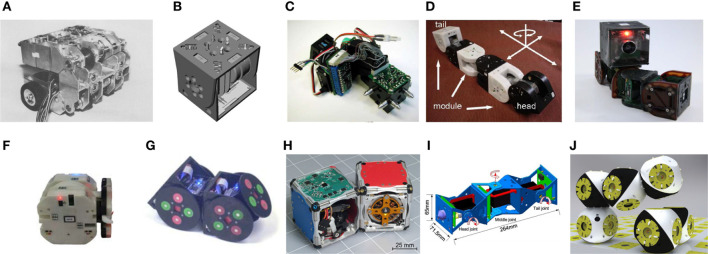
Cell-inspired robots. (A) The Mark II implementation of CEBOT [Reprinted by permission from Springer Nature Terms and Conditions for RightsLink Permissions Springer Customer Service Centre GmbH: Springer Nature, Journal of Intelligent and Robotic Systems (Fukuda and Nakagawa, 1990), CC BY (1990)]; (B) rendering of a single module of PolyBot model G3 (© [2018] IEEE. Reprinted, with permission, from Yim et al., 2002); (C) a single module of CONRO robot (Payne et al., 2004) (Reprinted by permission from Rubenstein, Payne, Will, Shen/USC, ISI); (D) a cluster of modules approaching a docking station cluster of M-TRAN robot (© [2018] IEEE. Reprinted, with permission, from Murata et al., 2006); (E) a cluster of modules of CKbot with camera module on top (© [2018] IEEE. Reprinted, with permission, from Yim et al., 2007); (F) a single module of Sambot (© [2018] IEEE. Reprinted, with permission, from Wei et al., 2011); (G) two modules of SMORES (© [2018] IEEE. Reprinted, with permission, from Davey et al., 2012); (H) two modules of M-Blocks (© [2018] IEEE. Reprinted, with permission, from Romanishin et al., 2013); (I) a single module of the modular self-reconfigurable robot presented in Qiao et al. (2014) (Reprinted with permission from License Attribution 3.0 Unported (CC BY 3.0)); (J) Roombots: two clusters composed of two modules connected to a grid during assembly (© [2018] IEEE. Reprinted, with permission, from Spröwitz et al., 2010).